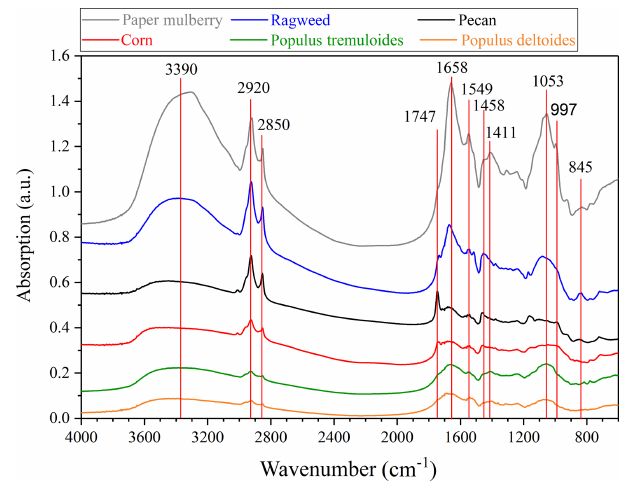
Figure 2. Transmission FTIR spectra of six pollen species investi- gated in this work.